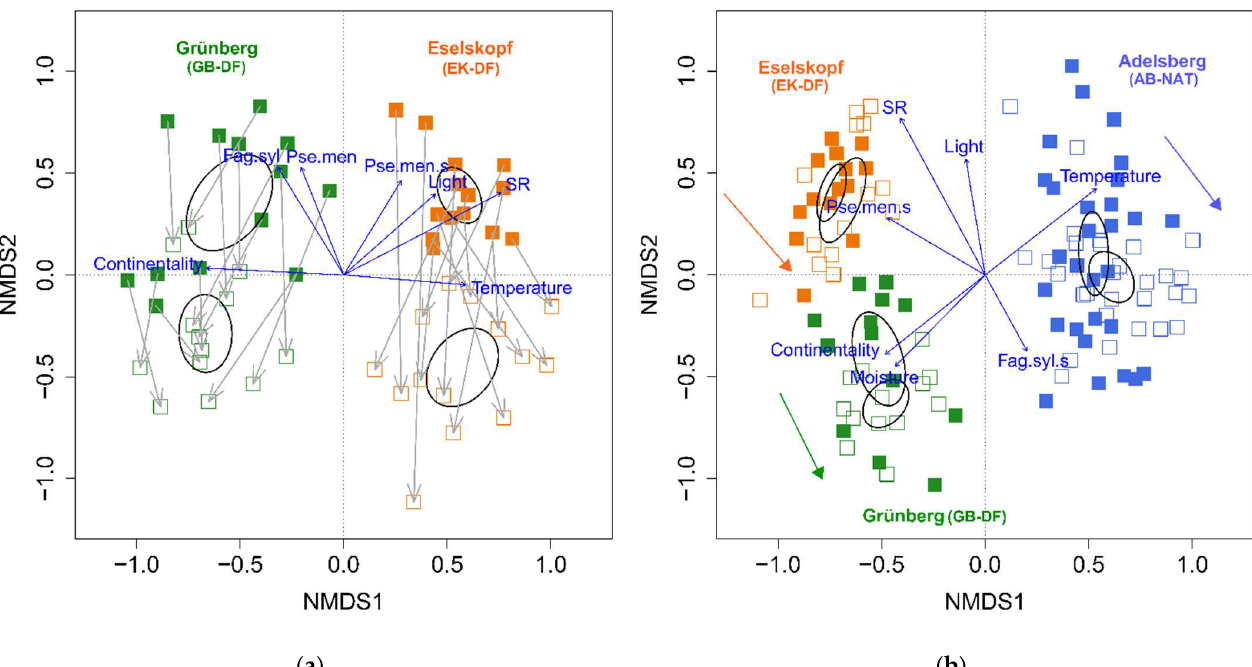
Figure 4. Two-dimensional NMDS ordination diagram of species abundance data of the field layer (shrub, herb and moss layer) for ( a ) the two SFR dominated by Douglas fir (stress = 0.2013) and ( b ) for all three investigated SFR (stress = 0.1899) for the two survey times. Grey arrows in ( a ) indicate the shift of individual subplots between the survey times. The colored arrows in ( b ) indicate the general shift in species composition for the respective SFRs. The ellipses give the standard error around the centroids for each observation and SFR. A bi-plot was created by correlating axes values with mean EIVs, the species richness (SR) and the cover of F. sylvatica (Fag.syl) and P. menziesii (Pse.men) in the shrub (_s) and herb layer. Only significant correlations with p < 0.001 are displayed. Table 3. Mean axes scores ( ± SE) of the NMDS ordination for the first and second survey displayed in Figure 4. Significantly higher scores between the first and second survey according to paired t-tests are written in bold. For the ordination of the three SFR (Figure 4b), both axes were additionally combined into one axis score (NMDS1-NMDS2) to identify significant shifts across axes. First Survey Second Survey p NAT) remained along the first axis over time.